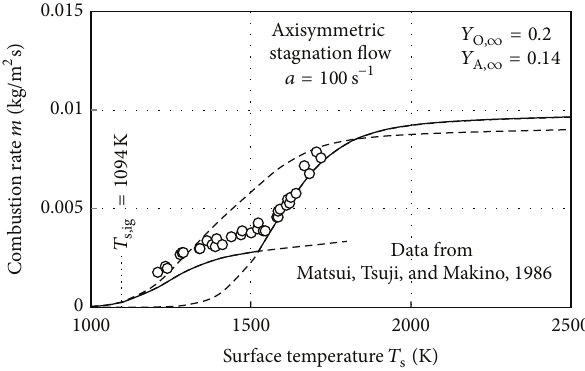
Figure 9: Combustion rate in humid airflow with the H 2 O mass- = 0.14 , as a function of the surface temperature 𝑇 fraction 𝑌 A ,∞ Data points are experimental [39] and curves are calculated by use of the explicit combustion-rate